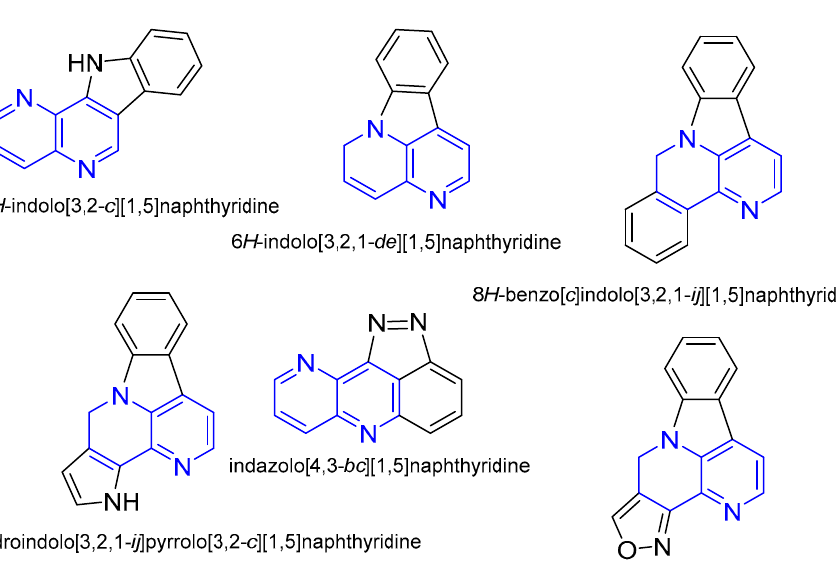
Figure 4. Examples of indolo and indazolo[1,5]naphthyridine derivatives.